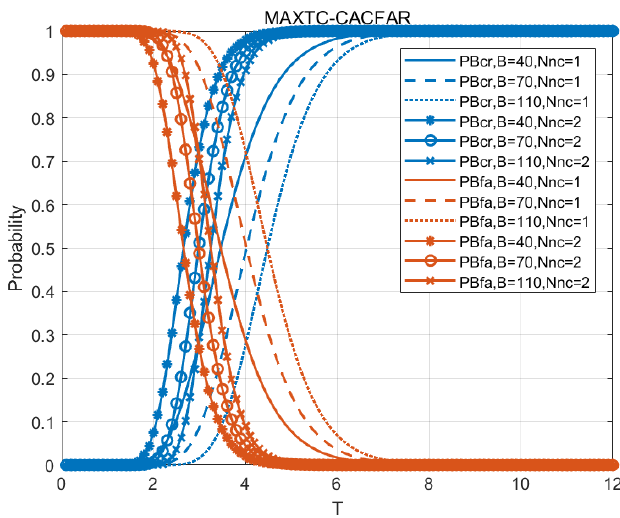
Figure 11. P Bcr and P Bfa versus multiple parameter Figure 11. P (cid:2886)(cid:2913)(cid:2928) and P (cid:2886)(cid:2916)(cid:2911) versus multiple parameter T .